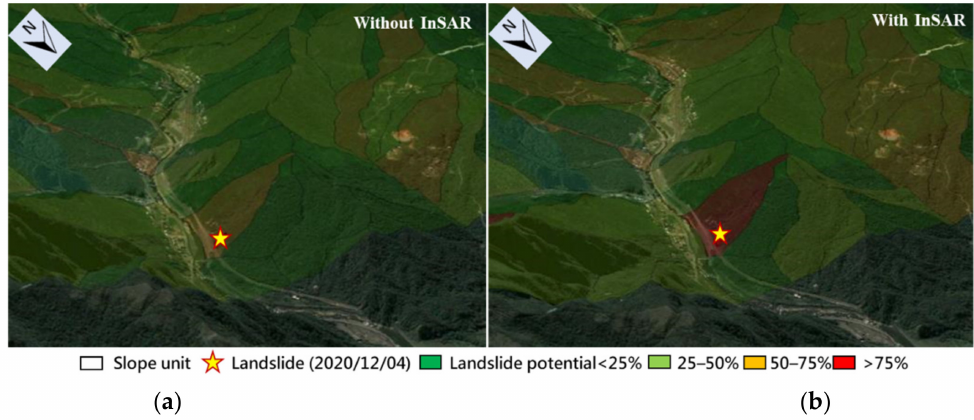
Figure 7. Landslide susceptibility analysis for the 2020 landslide case in northern Taiwan: ( a ) with InSAR data; ( b ) without InSAR